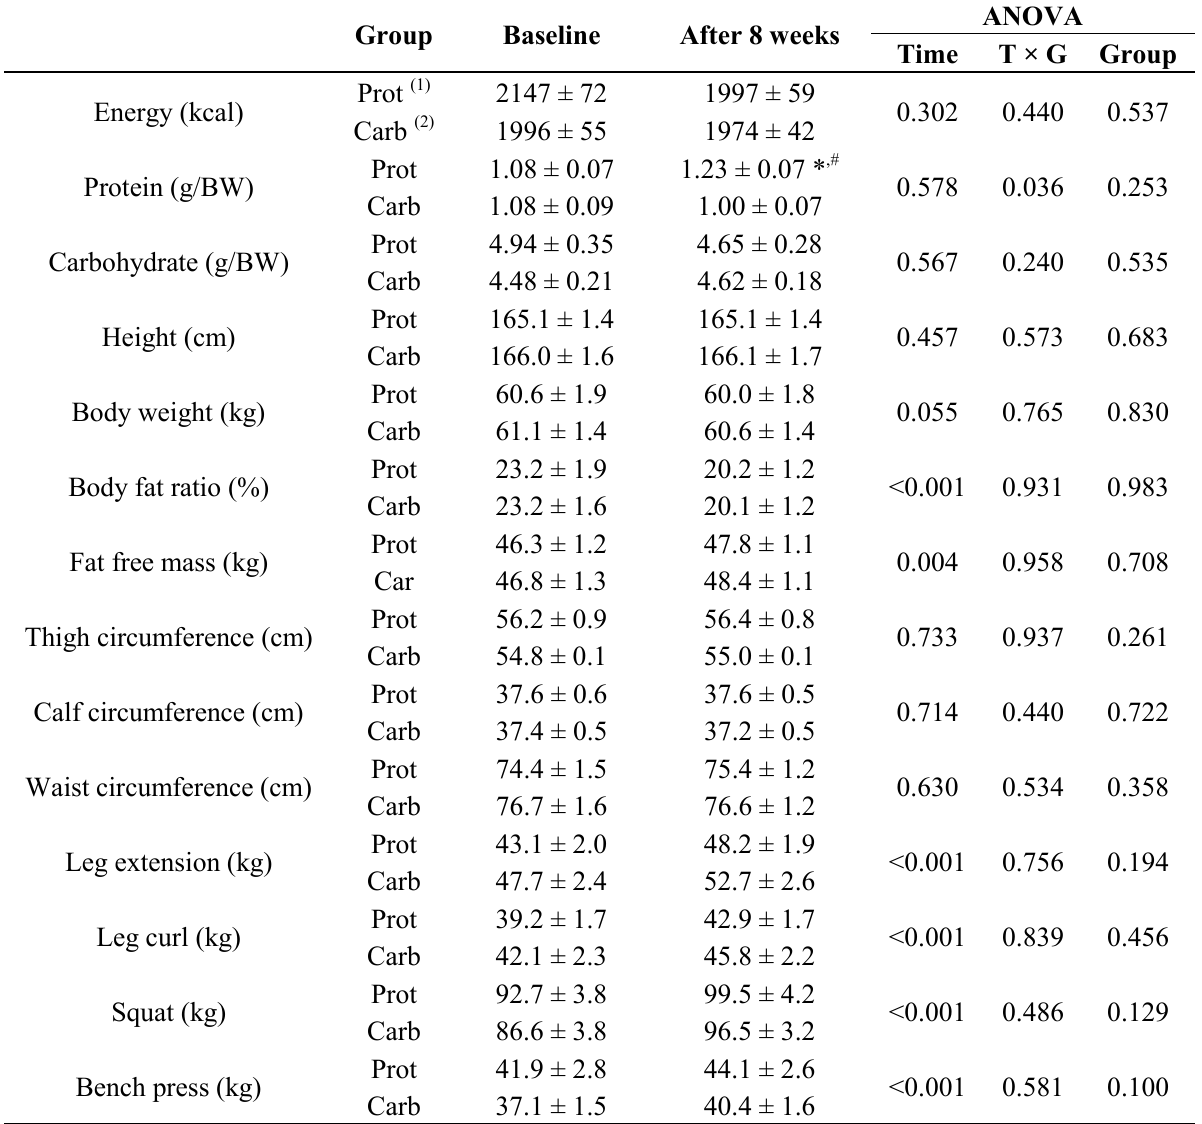
Table 2. Participant characteristics. All values are expressed as mean ± SE. ANOVA, a repeated two-way analysis of variance. T × G, effect of time × group